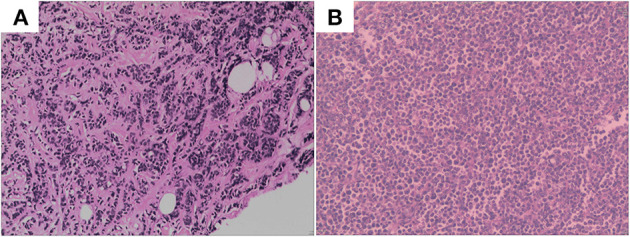
(A) Hematoxylin and eosin-stained section of primary lesion. (B) Hematoxylin and eosin-stained section of metastasis lesion of ovary.